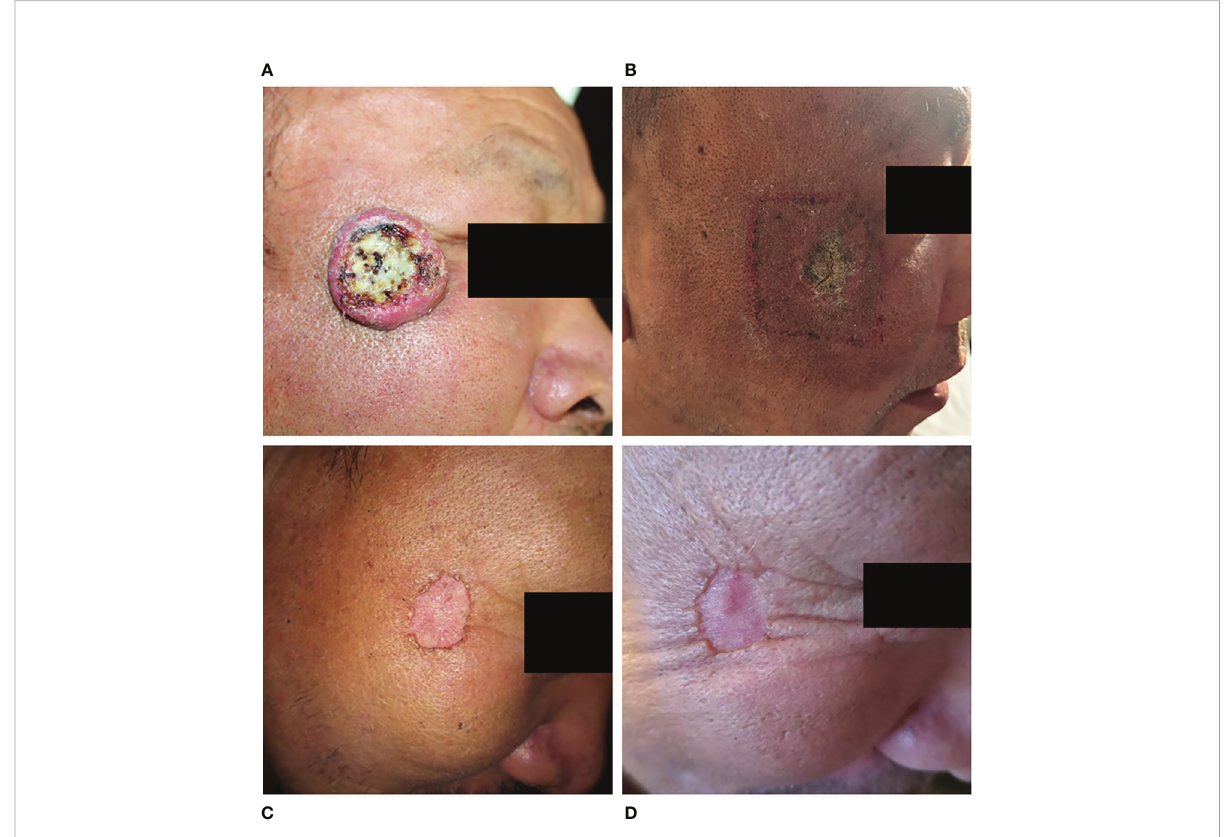
FIGURE 1 Change in facial lesions before and after radiotherapy. (A) , The facial lesions appeared as “ crater-like ” ulcers before the treatment; (B) , By the end of radiotherapy, the facial lesions regressed signi fi cantly and formed dry scabs; (C) , One year after radiotherapy, the facial lesions basically disappeared; (D) , Two years after radiotherapy, the edge of the lesions fl attened compared to the fi rst